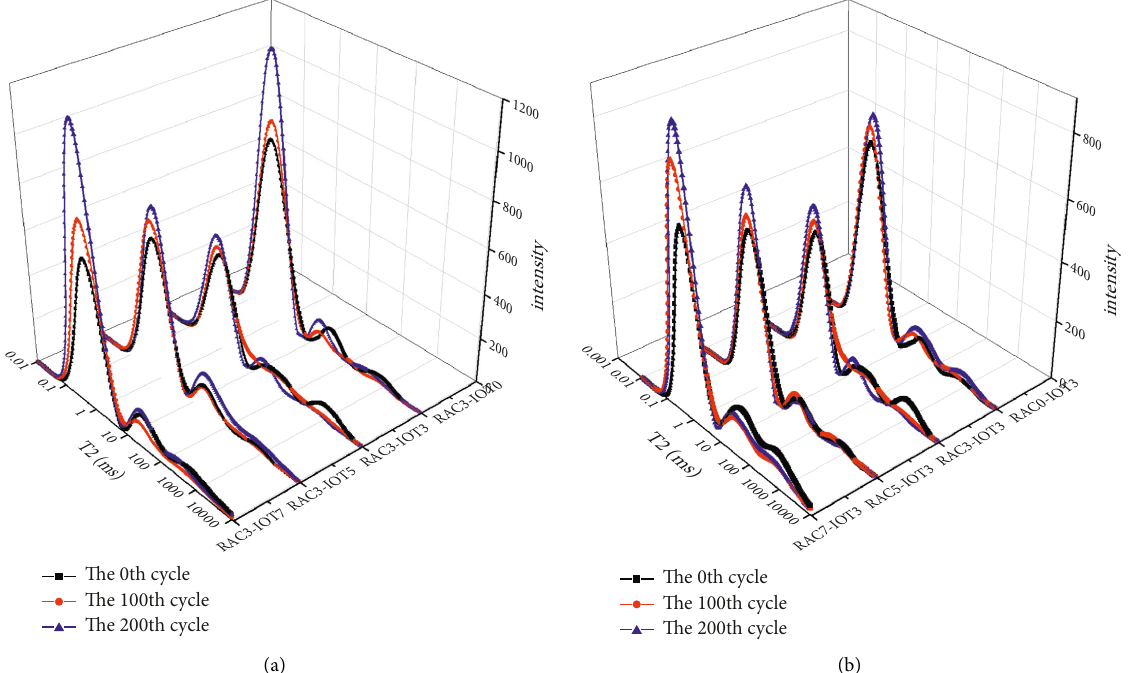
Figure 13: T2 Atlas before F-Tcycles with different mixing ratios: (a) the replacement rate of RCA is 30%; (b) the replacement rate of IOTis 30%.